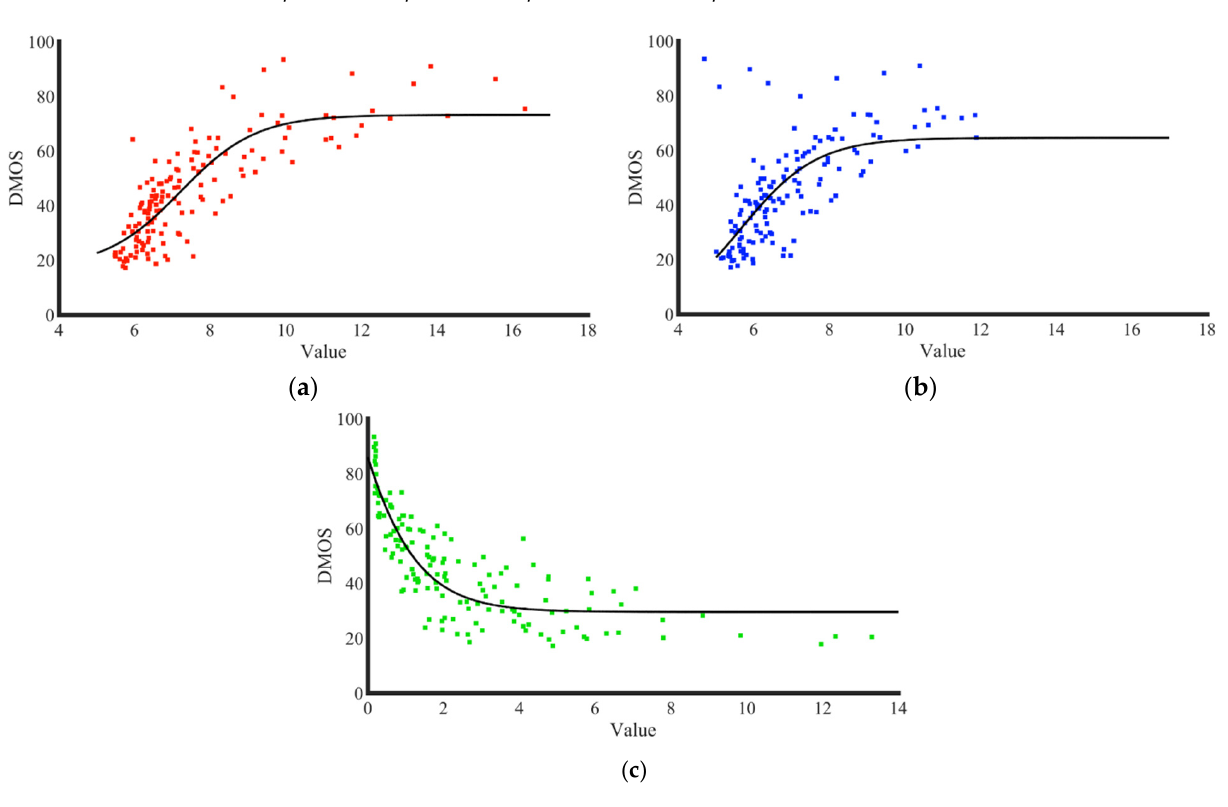
Figure 21. Fitting curves of three methods: ( a ) the fitting curve of proposed method; ( b ) the fitting curve of reference [14] method; ( c ) the fitting curve of Tenegrad method.